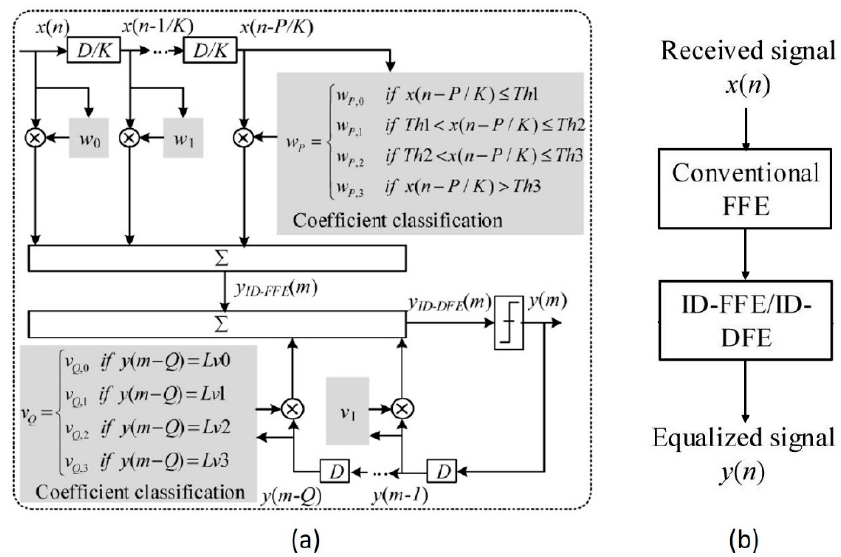
Figure 11. ( a ) The detailed structure of (P-1)-tap ID-FFE and Q-tap ID-DFE. ( b ) The block diagram of the pre-FFE + ID-FFE/ID-DFE (reprinted from [37] with open access from OSA).